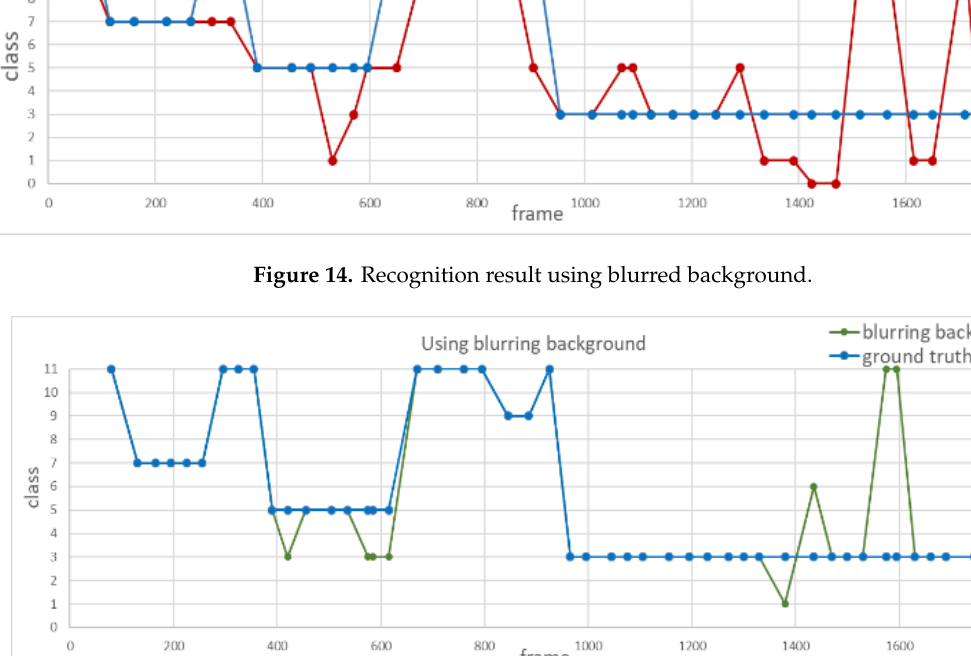
Figure 15. Recognition result using black background.